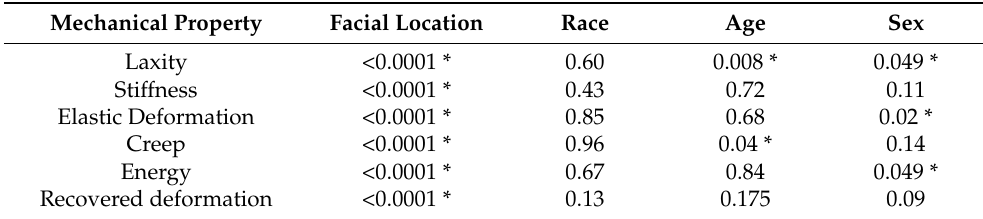
Table 2. Main effect contributions by facial location, race, age, and sex to measured mechanical properties. p values from linear mixed model (* p <